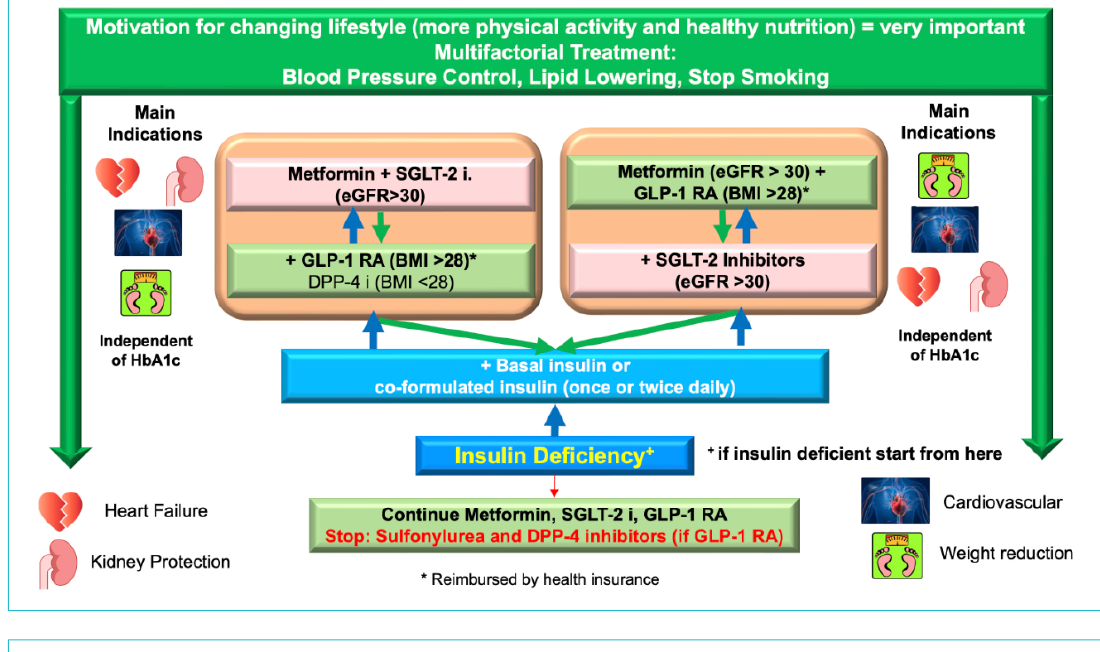
Figure 2: Summary of cardiovascular outcome trials with SGLT-2 inhibitors and GLP-1 receptor agonists in type 2 diabetes mellitus